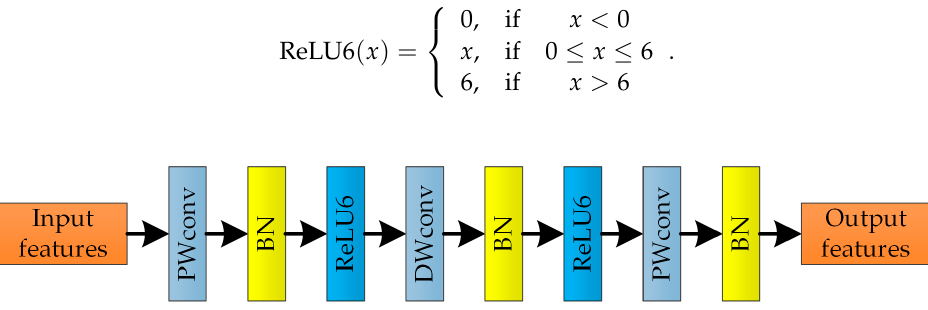
Figure 4. The unit of the inverted residual structure.